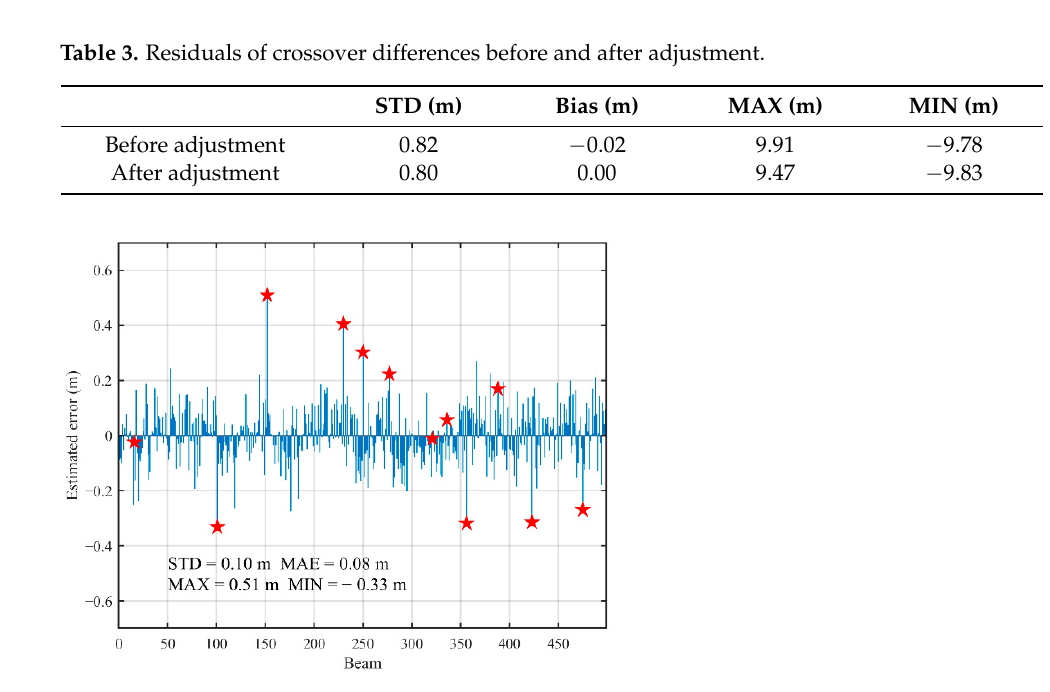
Figure 8. Histogram of estimated systematic bias of all beams (blue columns) from the ICESat-2 simulation validation. The simulation data is marked by the red star and will be shown in detail.